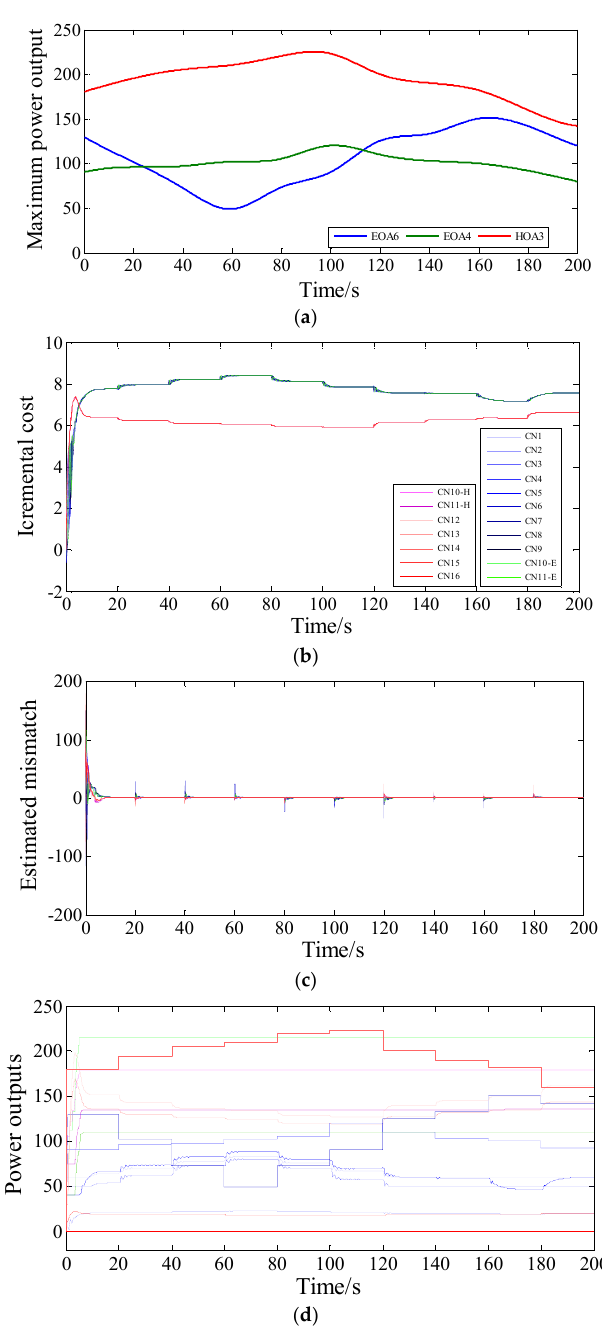
Figure 8. Case study 4, maximum power output varying: ( a ) maximum power output; ( b ) estimated electrical and heat incremental cost; ( c ) estimated electrical and heat power mismatch; and ( d ) electrical and heat power